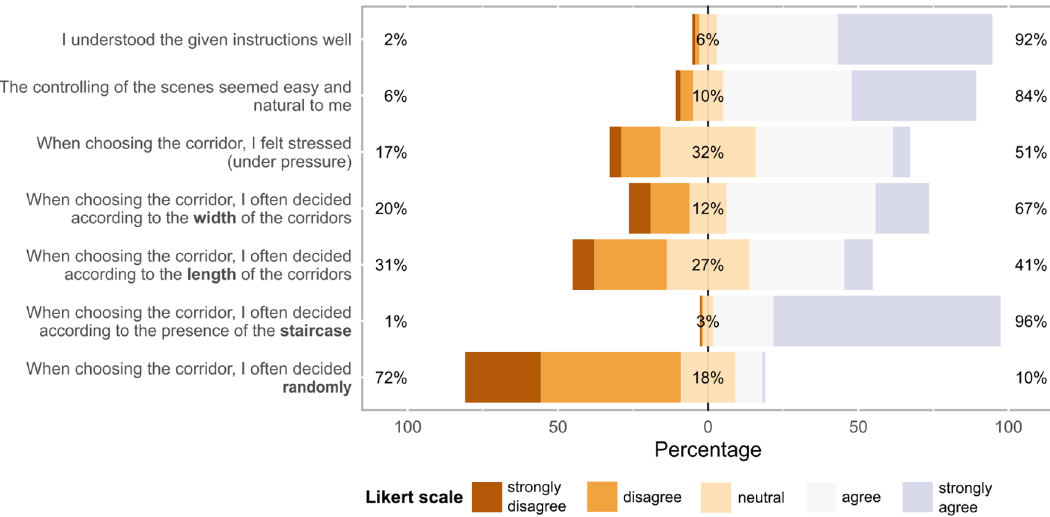
Figure 6. Summary of respondent responses to the electronic